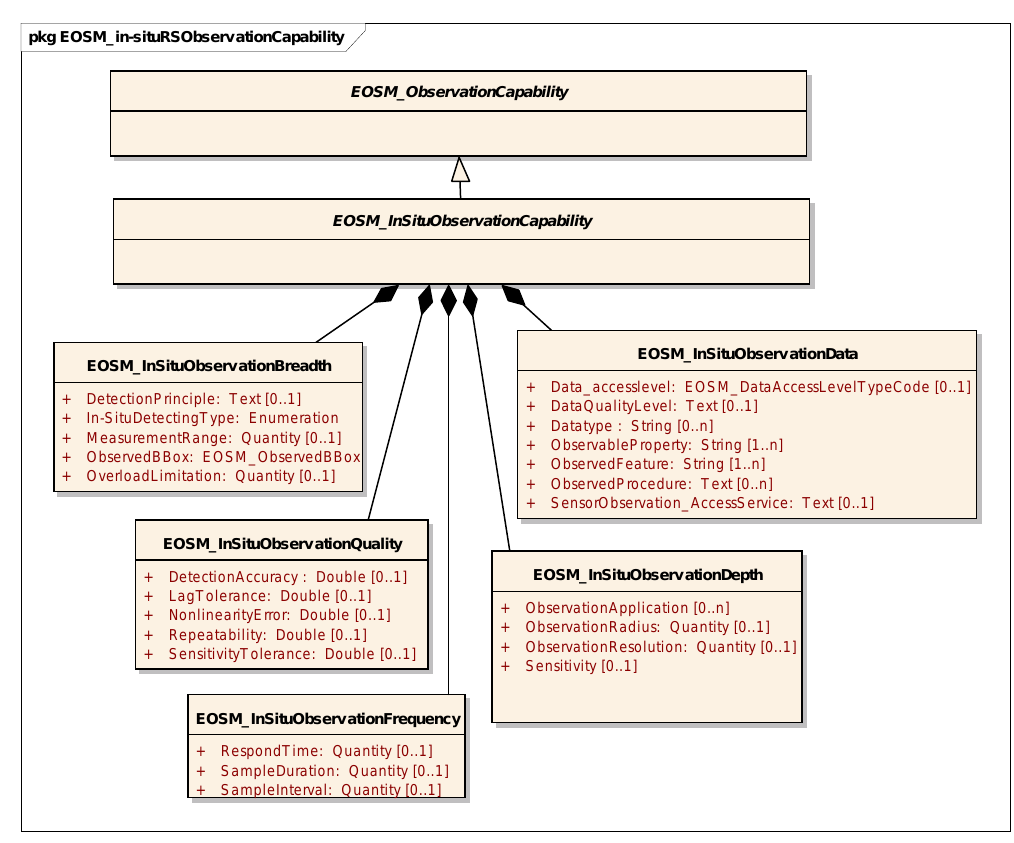
Figure 7. In situ sensor observation capability metadata